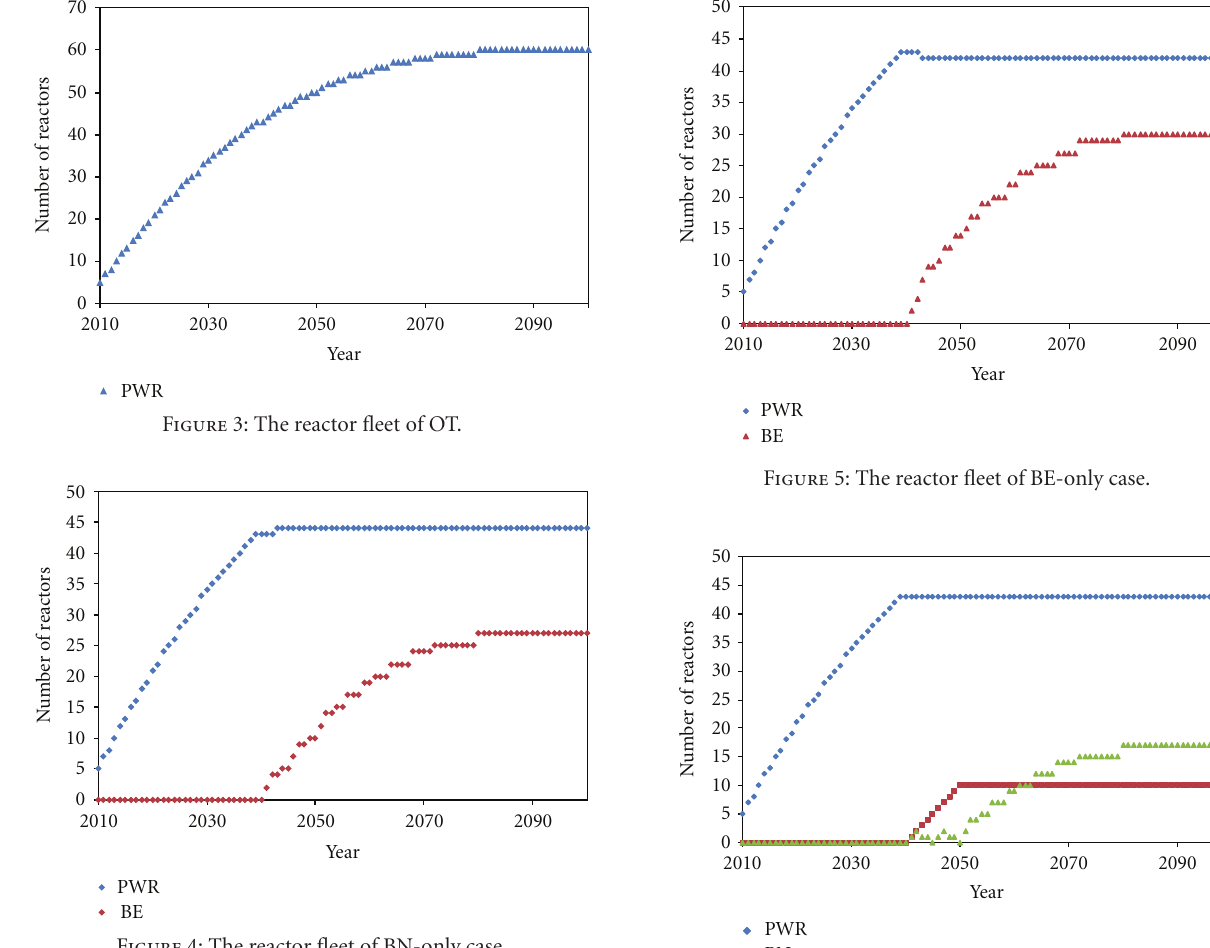
Figure 4: The reactor fleet of BN-only case.